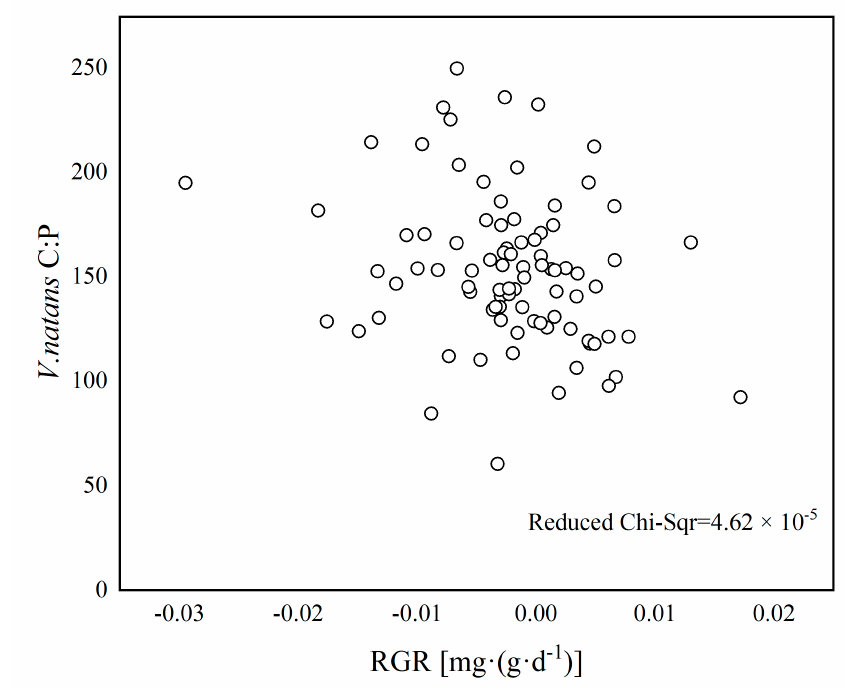
Figure 9. The relationship between V. natans C:P and relative growth rate